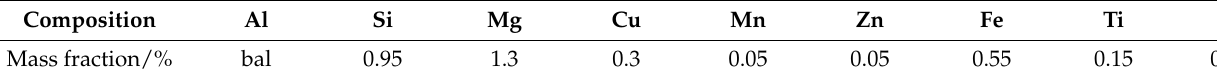
Table 1. The chemical components of 6061aluminum alloy powder.